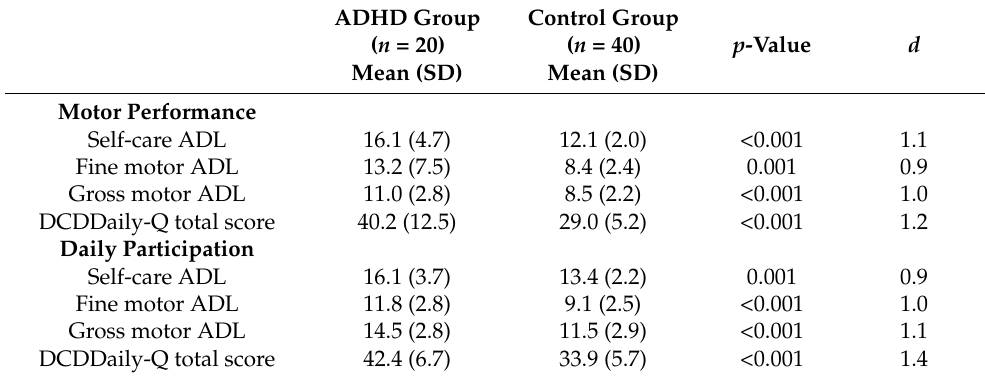
Table 3. Differences in performance and participation between ADHD and control groups ( n =